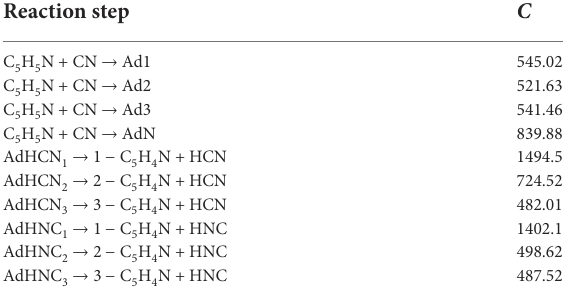
TABLE 2 Reaction step and values of the capture coefficient C (in E h /Bohr 6 ) for the processes without a barrier studied in this